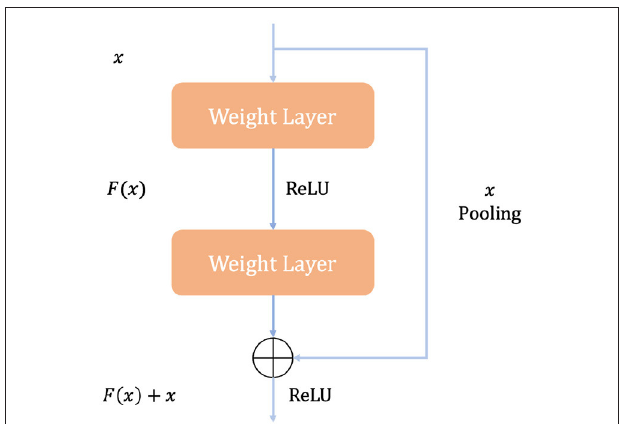
FIGURE 4 | The basic block of